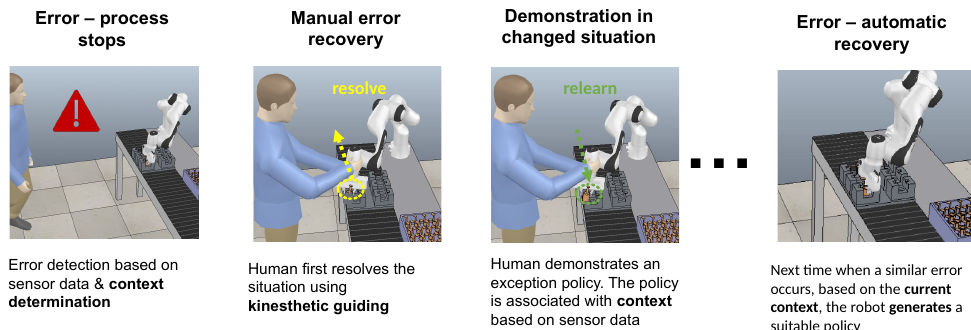
Figure 1. Simplified exception handling workflow [6]. This paper is about context determination, which is an essential requirement of the